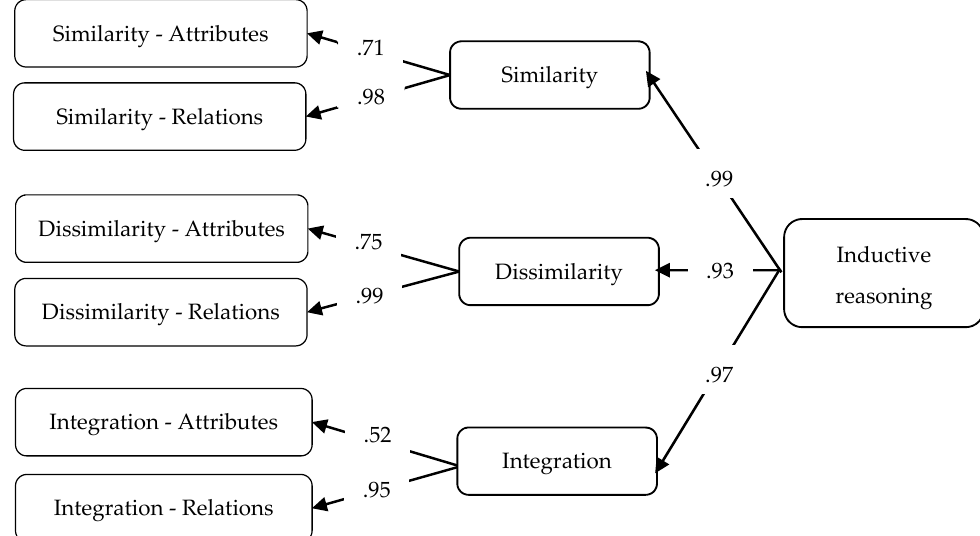
Figure 5. Results of the hierarchical model (Christou and Papageorgiou 2007, p. 63) with factor loadings.